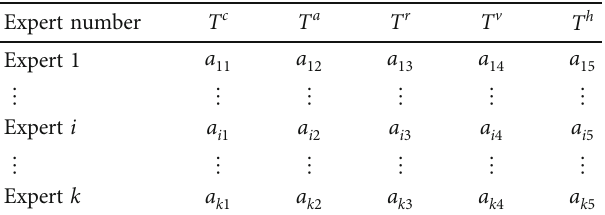
Table 1: Expert opinion evaluation